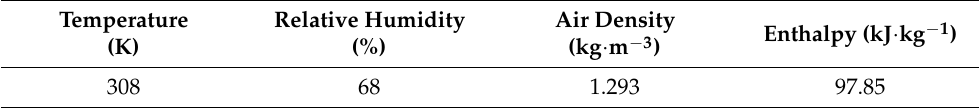
Table 3. Calculation parameters of air outside the subway car in summer.